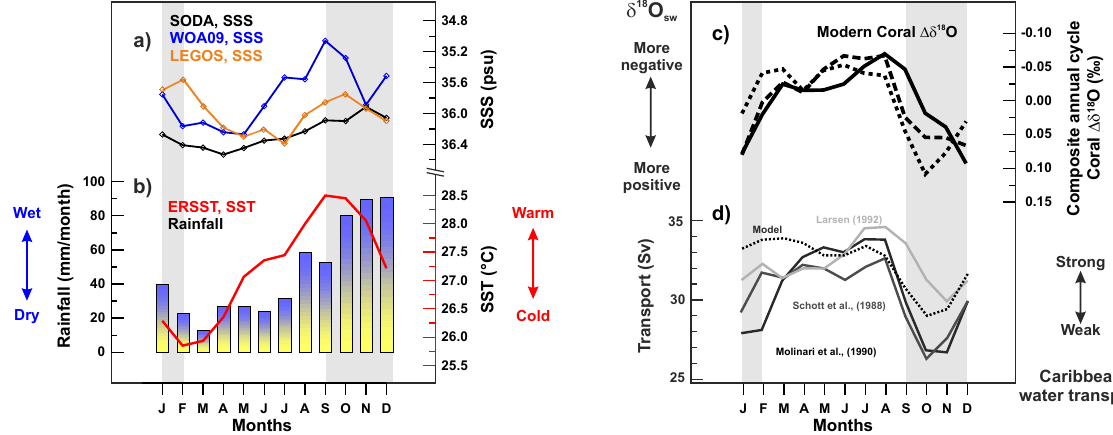
Fig. 10. Left panel: monthly mean climatology of environmental parameters at the study site, Bonaire. (a) Composite annual sea surface salinity (SSS) cycles from World Ocean Atlas 09 (Antonov et al., 2010) in a 1 ◦ × 1 ◦ gridbox (blue), from CARTON-GIESE SODA v2p0p2- 4 (Carton and Giese, 2008) in a 0.5 ◦ × 0.5 ◦ gridbox (black) and from Sea Surface Salinity Observation Service (Reverdin et al., 2007) in a 1°x1°gridbox (orange); (b) sea surface temperature (SST) monthly climatology for 1970–2000 from ERSSTv3b (Smith et al., 2008) in a 2 ◦ × 2 ◦ gridbox (red line) and climatology of monthly mean precipitation for the same period from UEA CRU Hulme Global prcp in a gridbox centred at 67.5 and 12.5 ◦ (Hulme et al., 1998) (vertical bars). Right panels: (c) composite annual coral 1δ 18 O cycle of three modern corals, 1912 AD (dashed line), 1957AD (dotted line) and 2009AD (solid line) calculated as previously described (cf. Fig. 6); (d) modelled (black dashed line) and observed annual cycle of the Florida Current (modified from Johns et al.,